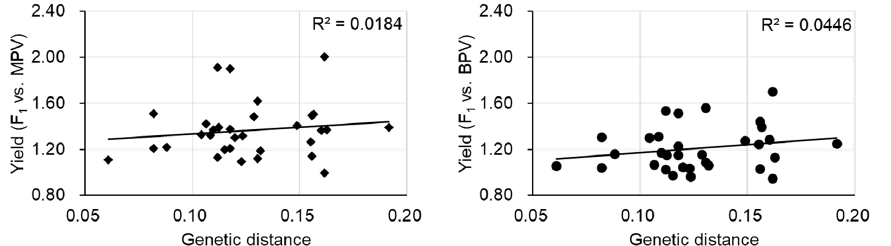
Figure 1. The relationship between yield heterosis and genetic distance of parental lines. MPV, mid-parent value, BPV, best parent value. Data are from [23].